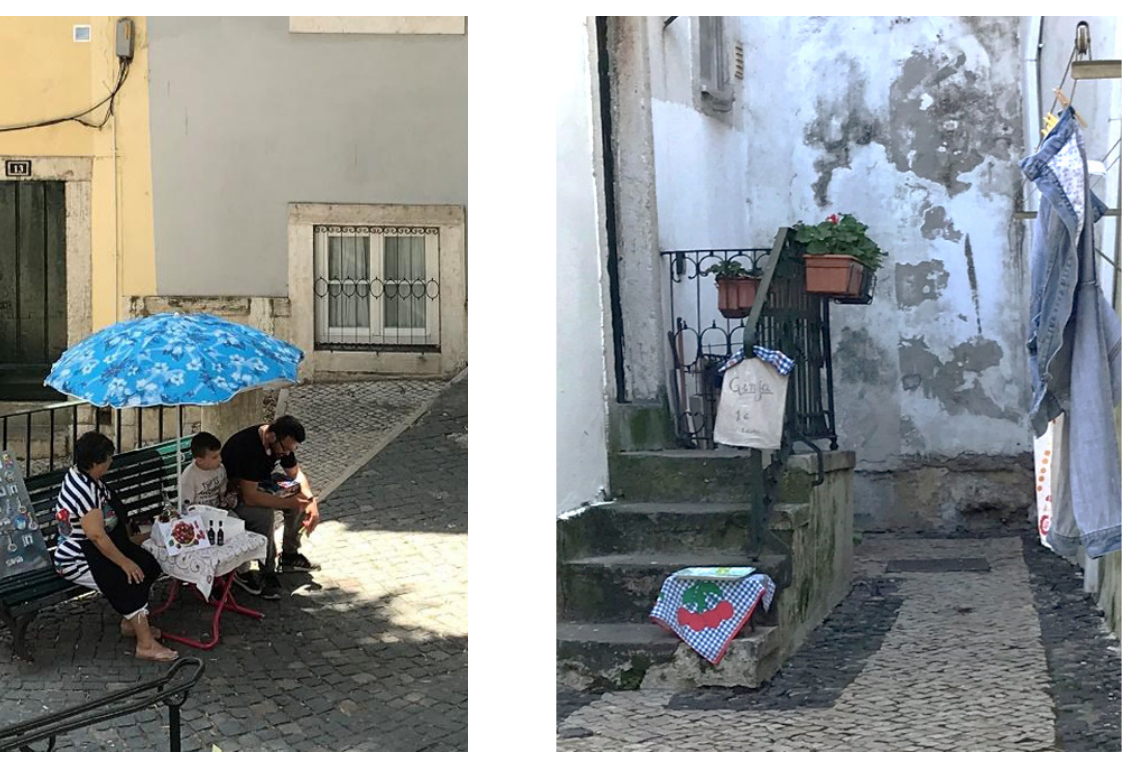
Figure 9. Escadinhas de Santo Estêvão, Alfama, July 2019. Figure 10. Beco da Cardosa, Alfama, December